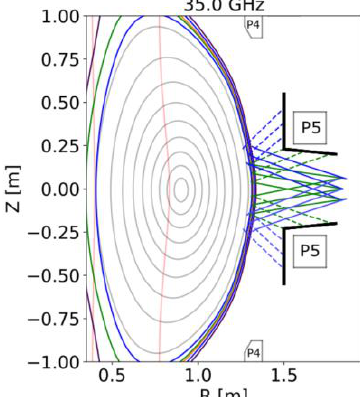
Fig. 13 : A schematic plot of the poloidal cross-section of the beams from the midplane launcher for I p = 800kA (green) and I p = 2000 kA (blue). The dashed lines represent the beam reflected from the plasma after coupling. Thick black lines represent “interceptor plates”.